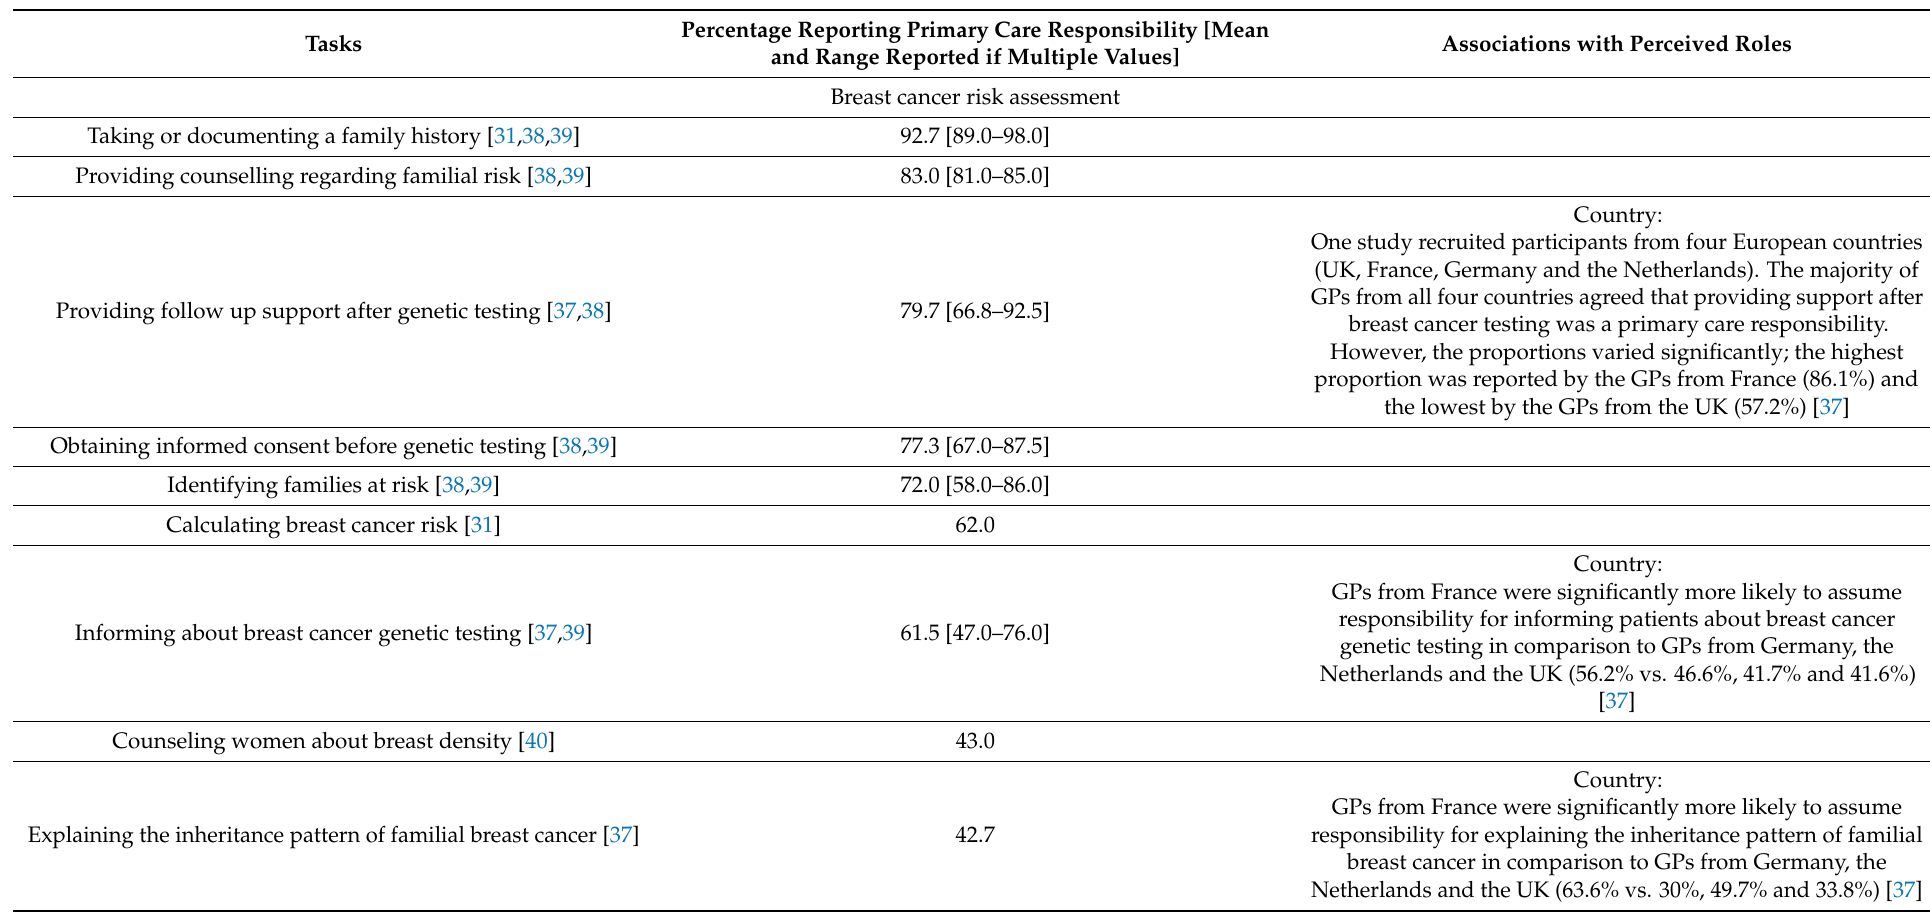
Table 2. Primary care providers’ perceived responsibilities in breast cancer risk assessment and primary